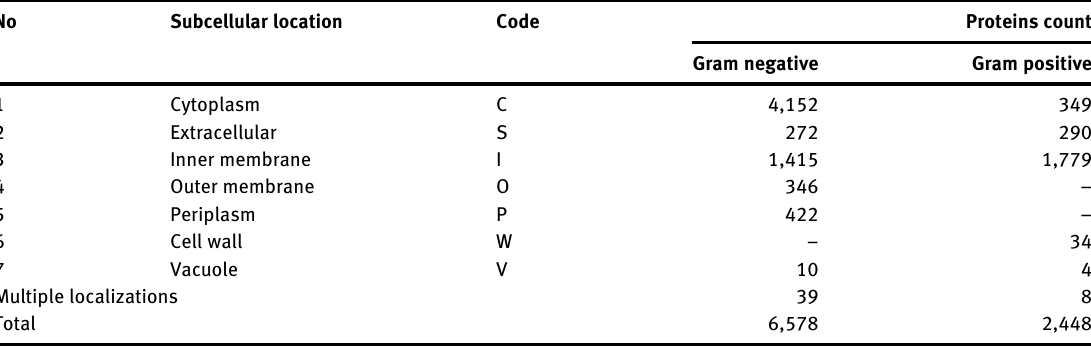
Table  : Prokaryotic benchmark datasets statistics. Code column indicates the subcellular location representation in our pre- dictive model. Gram-negative bacteria have fi ve major subcellular localization sites, namely, the cytoplasm, the periplasm, the inner membrane, the outer membrane, and the extracellular space, whereas Gram-positive bacteria do not have an outer cell membrane. However in these benchmark datasets cell wall is absent in Gram-negative dataset and in Gram-positive bacteria,we observe the lack of periplasm